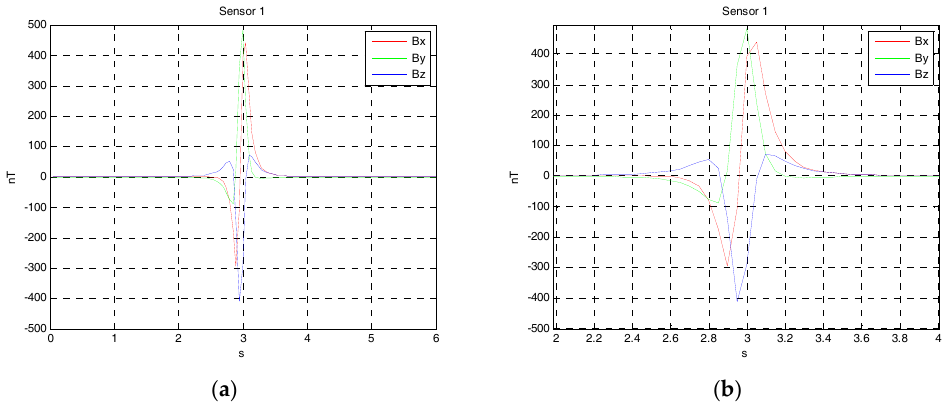
Figure 5. ( a ) The three components alternating magnetic field data acquire by sensor 1 from the time of 0 s to 6 s; ( b ) The three components alternating magnetic field data acquire by sensor 1 from the time of 2 s to 4 s.